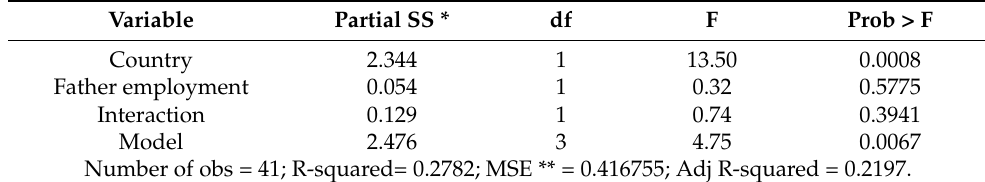
Table 6. Fathers’ employment estimates.